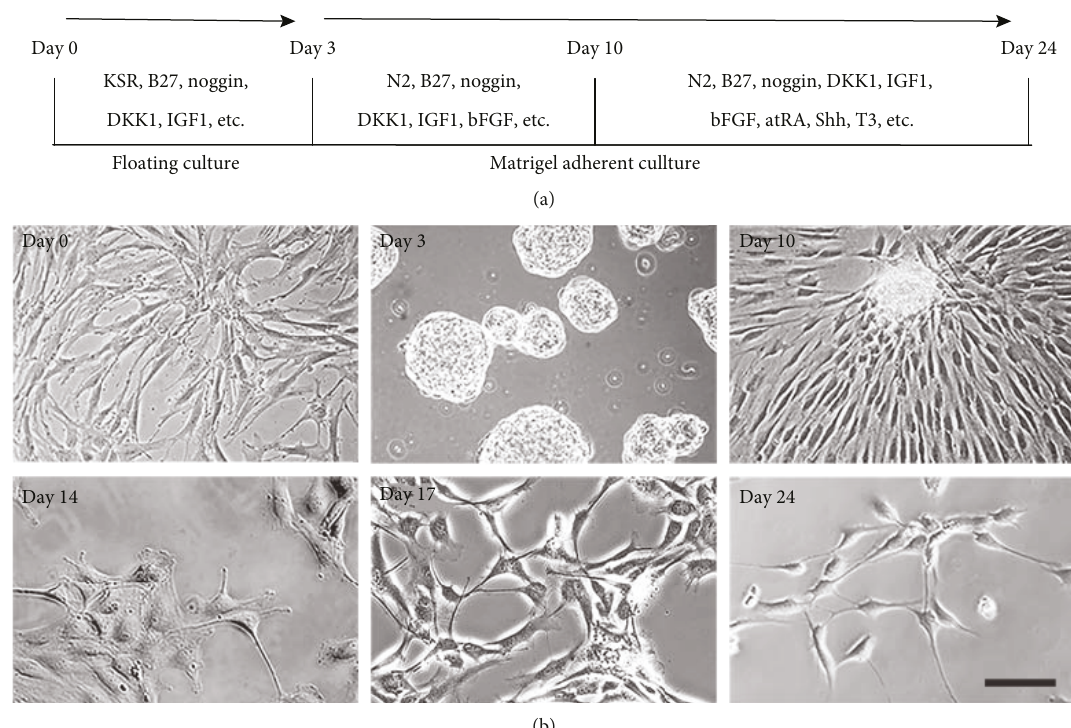
Figure 2: Morphological changes during in vitro retinal di ff erentiation. (a) Retinal di ff erentiation protocol. (b) Morphological changes of SHEDs during retinal induction. On day 3, large fl oating neurosphere-like masses were observed. After retinal cell (factor cocktail) induction on Matrigel, the cells became larger and extended cytoplasmic processes like neurites, cross-linking with adjacent cells about 14 days post-induction. At the end of induction (day 24), cells displayed the morphology of neuron-like cells. Scale bar: 50 μ